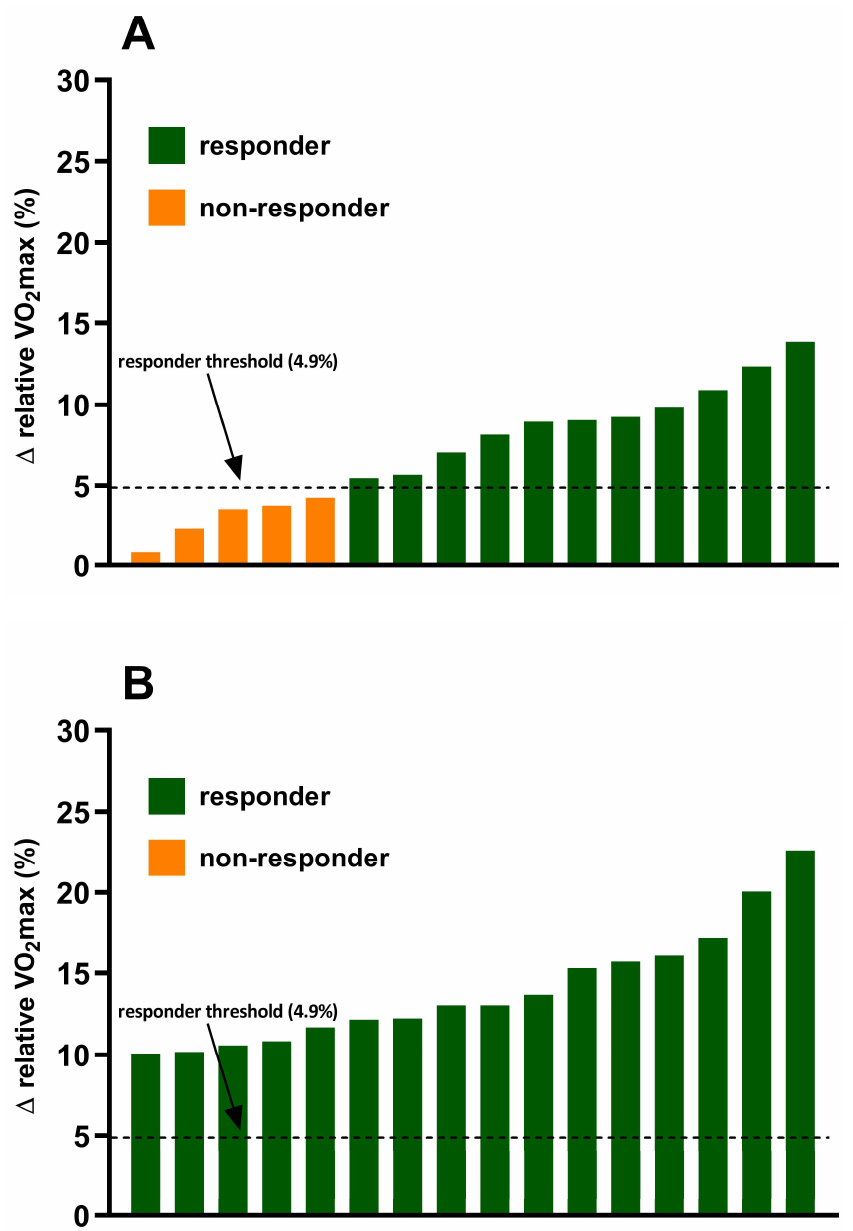
Figure 2. Inter-individual variability in VO 2max responses to exercise training in the ( A ) standardized MICT group and ( B ) personalized MICT + HIIT group.